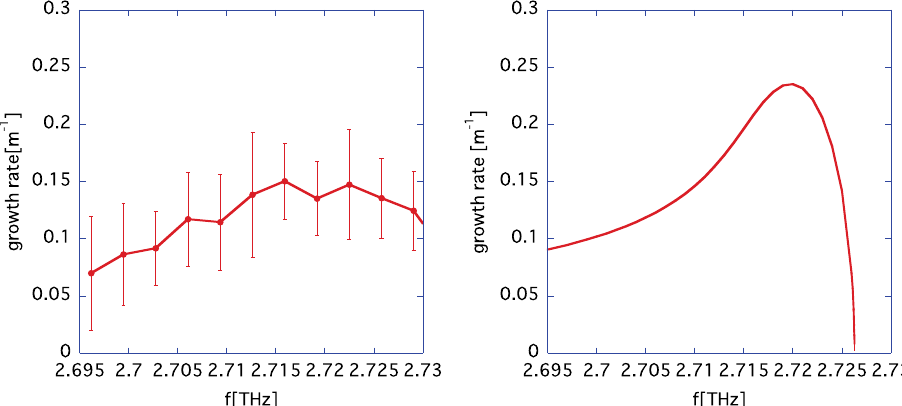
FIG. 4. The simulation (left) and the theoretical (right) results of the beam growth rate for R 0 ¼ 0 . 5 mm, γ 1 ¼ 13 . 7011 and γ 13 . 7392 . 2 ¼